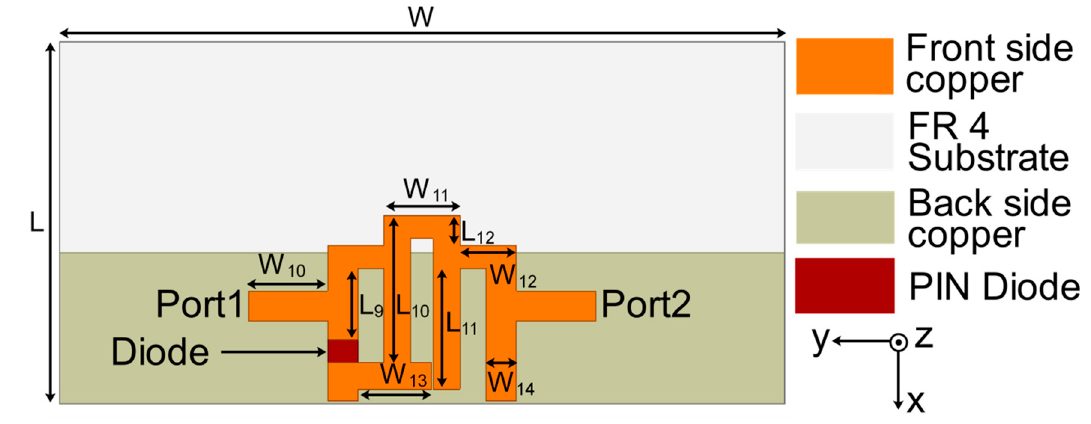
Figure 7. Bandstop filter construction with a single PIN diode.